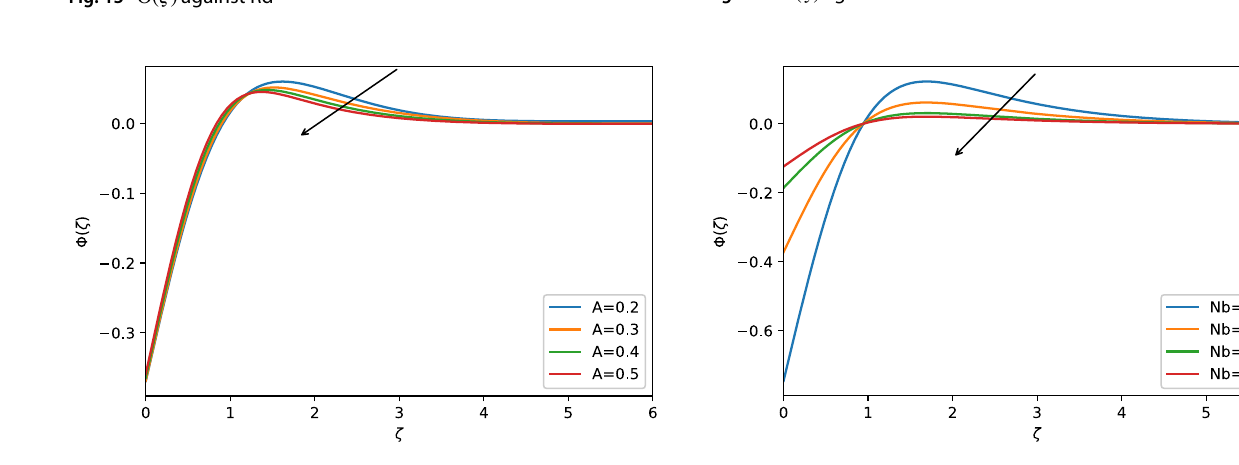
Fig. 15 Φ( 𝜁 ) against Le